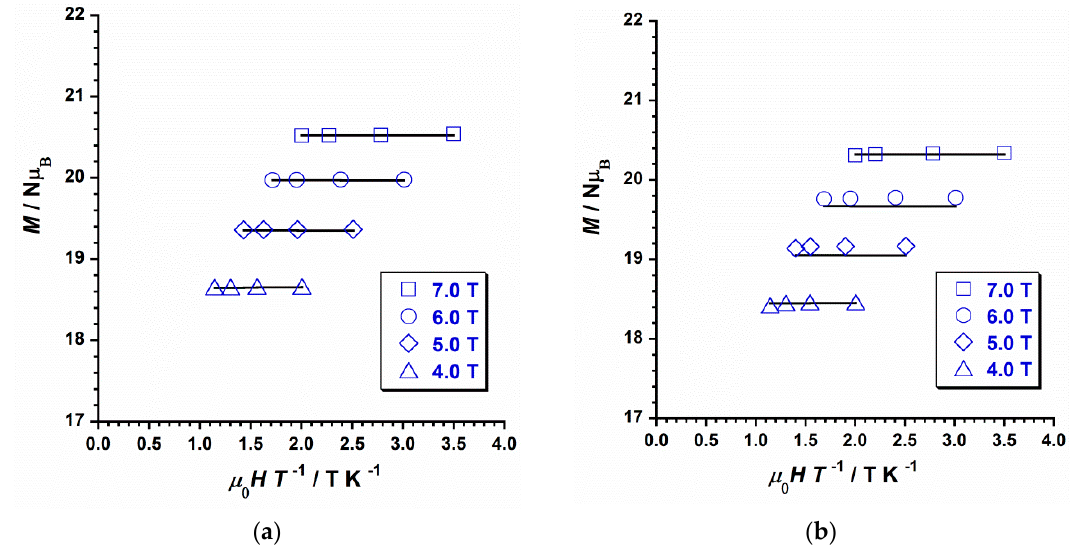
Figure 7. Plot of the reduced magnetization ( M / N μ B versus μ o H / T ) for 1 ( a ) and 2 ( b ) at 4, 5, 6 and 7 T fields and temperatures 2–5 K. The solid lines represent the best fit of the experimental data.